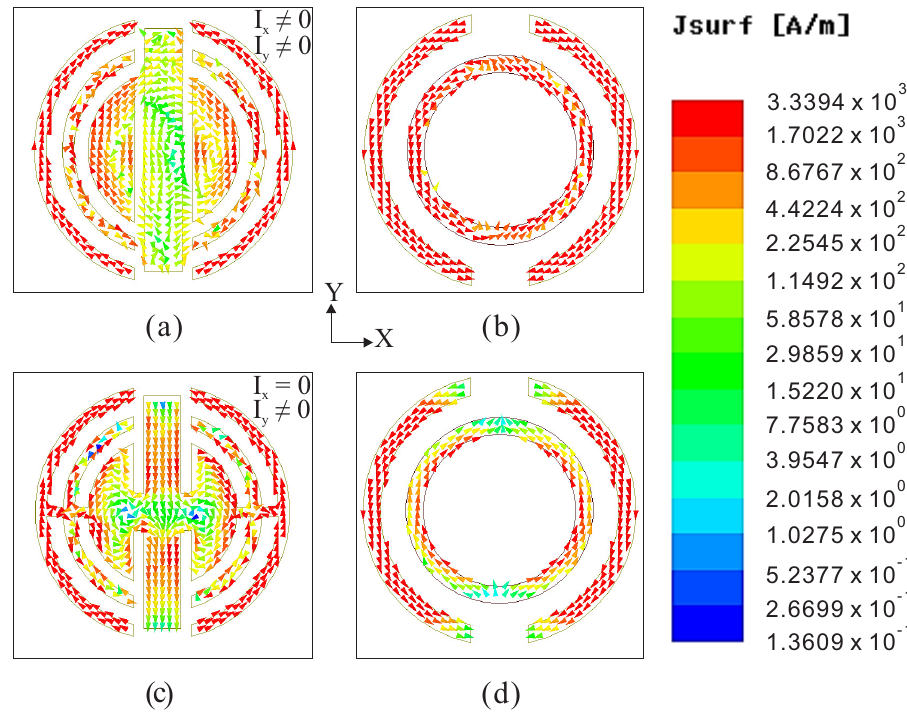
Figure 6. Surface current on the unit cell at 11.725 GHz when the dipole is not shorted with iterations: ( a ) Top layer. ( b ) Middle Layer. and surface current on the unit cell at 11.725 GHz when the dipole and iterations are shorted with each other: ( c ) Top layer. ( d ) Middle Layer. [ I x and I y represents the co- and x-pol